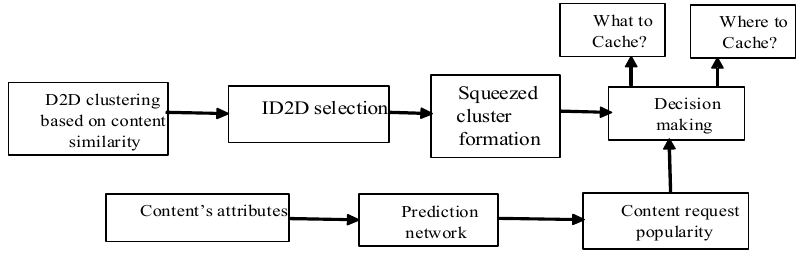
Figure 3. Content popularity prediction-based caching framework in D2D networks. Algorithm 1. Clustered-SVM to Predict Content Popularity and Implement Decision